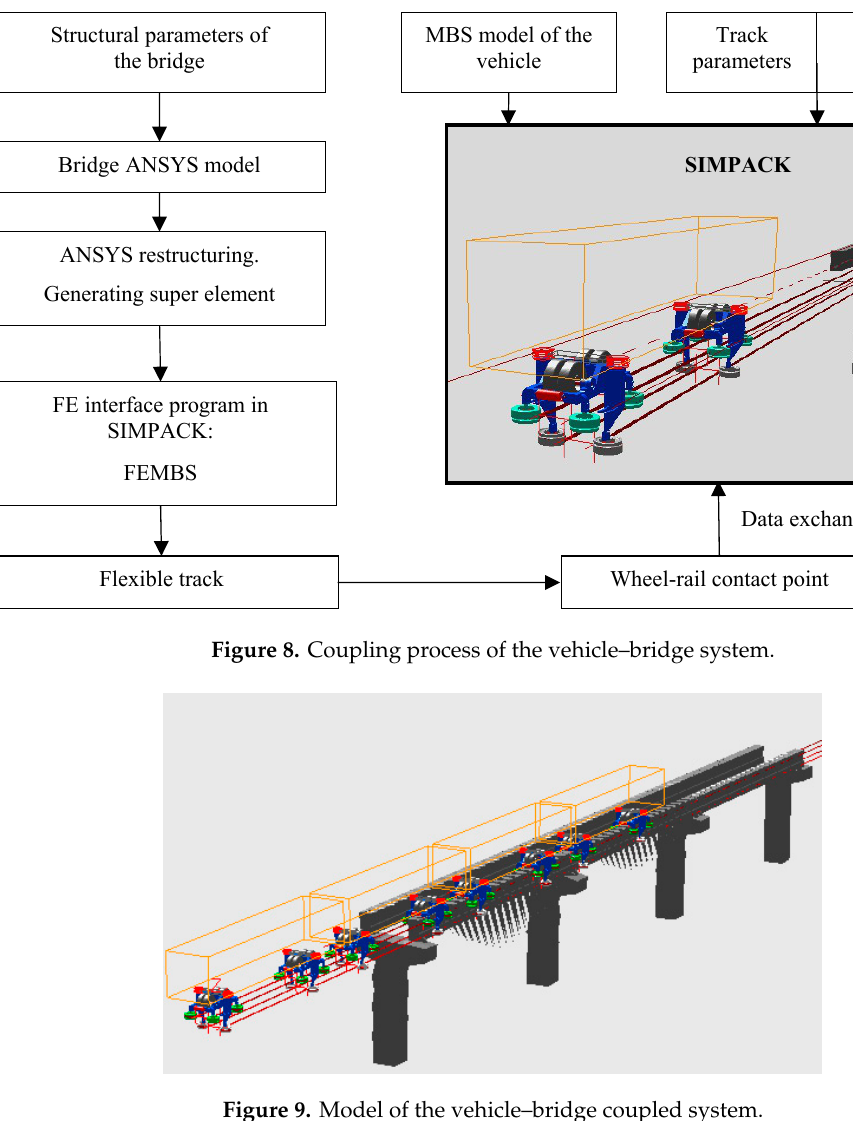
Figure 8. The surface roughness based on Japanese steel track irregularity 259